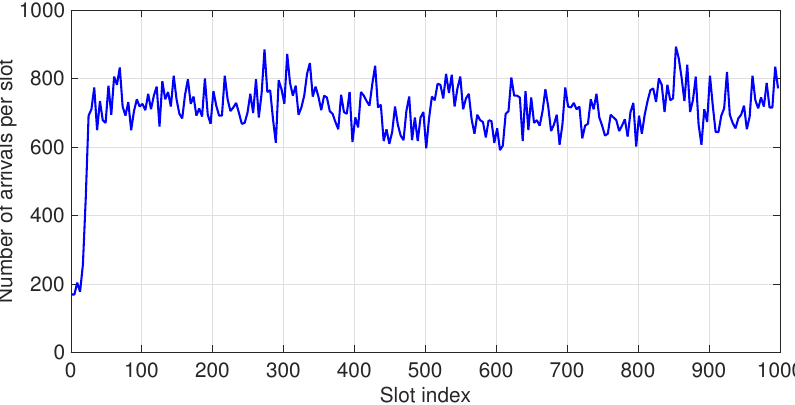
Figure 2. Trace sample of I/O arrival data from an enterprise cluster in WorldCup98 Workload [1:1000] [26]. The corresponding average arrival rate and PMR (Peak Mean Rate) are 1.56 and 19.65,